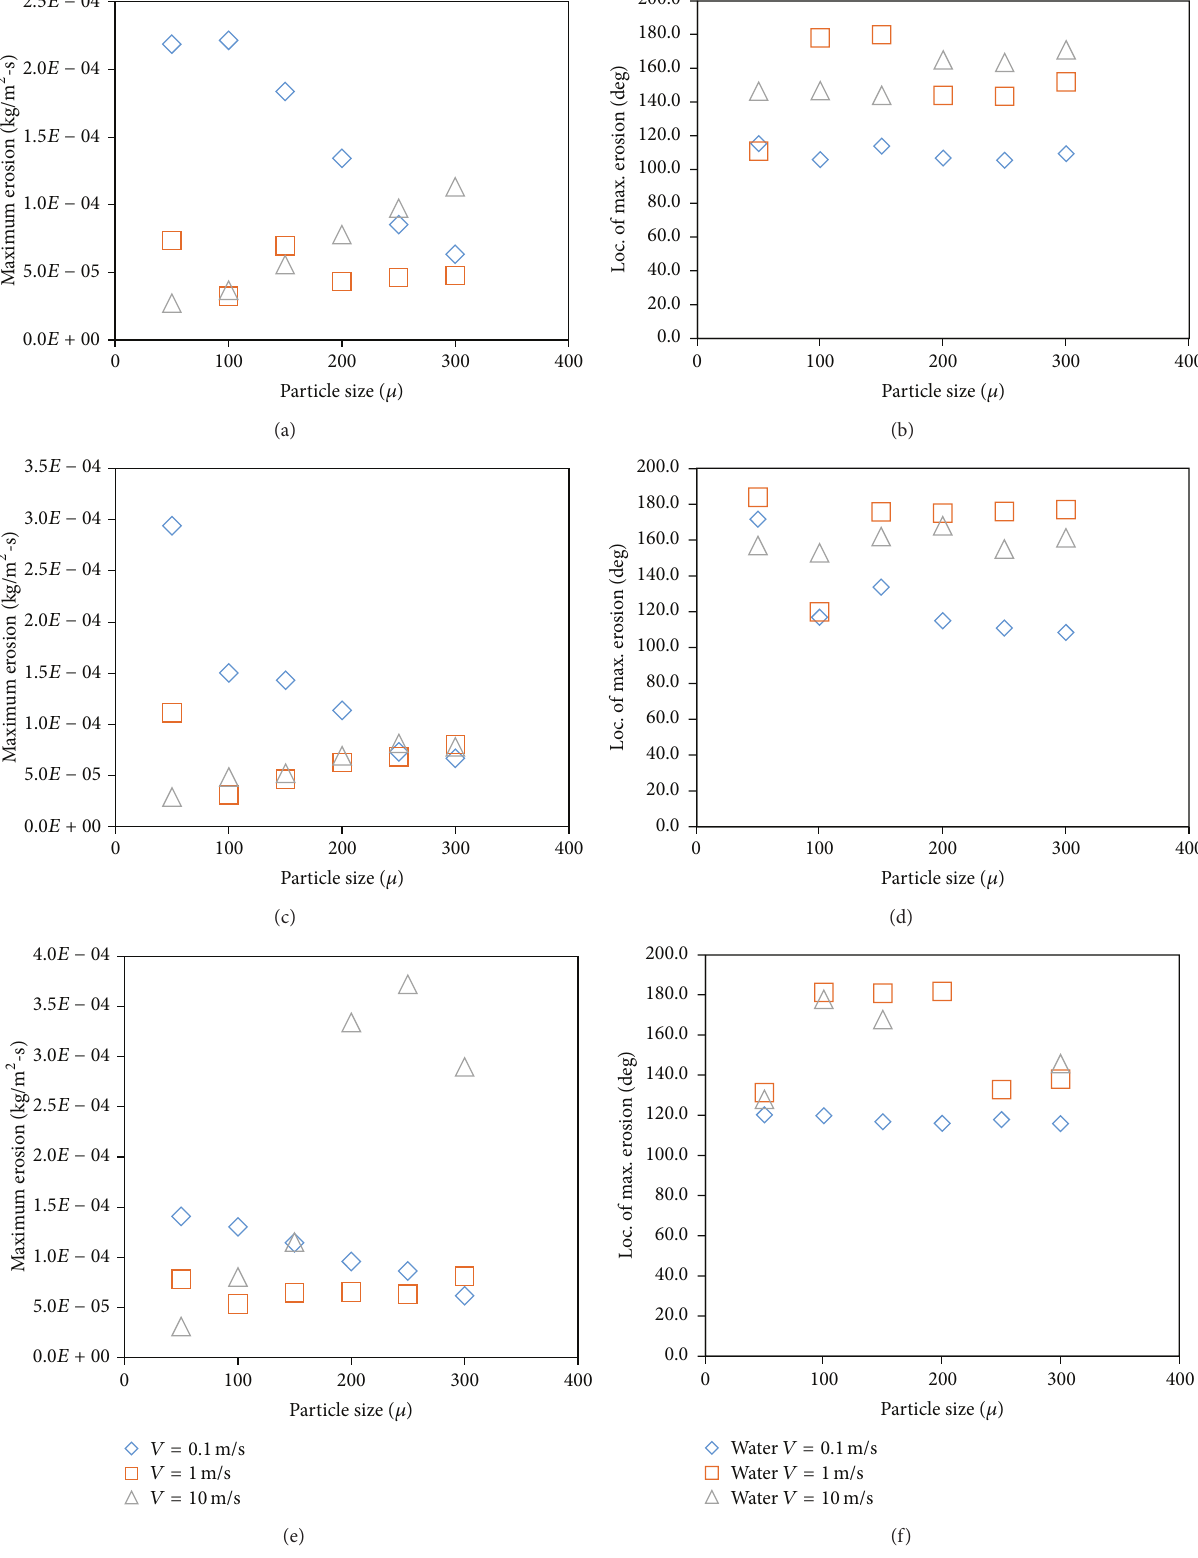
Figure 5: (a) Effect of water velocity on erosion ( 𝑟/𝐷 = 1.5 ). (b) Location of erosion with water velocities ( 𝑟/𝐷 = 1.5 ). (c) Effect of water velocity on erosion ( 𝑟/𝐷 = 2.5 ). (d) Location of erosion with water velocities ( 𝑟/𝐷 = 2.5 ). (e) Effect of water velocity on erosion ( 𝑟/𝐷 = 3.5 ). (f) Location of erosion with water velocities ( 𝑟/𝐷 = 3.5